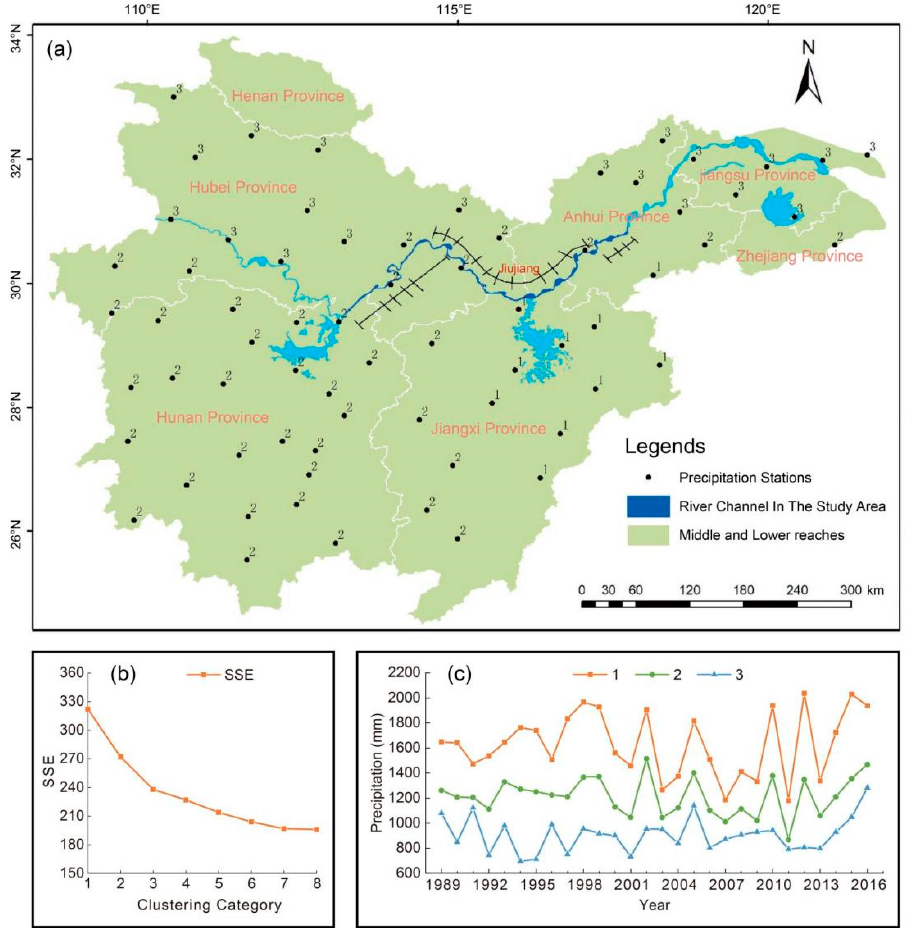
Figure 10. Cluster Analysis. ( a ): Clustering distribution of average precipitation in the middle and lower reaches of the Yangtze River basin; ( b ): Clustering category selection; ( c ): Changes in precipitation by clusters in the middle and lower reaches of the Yangtze River